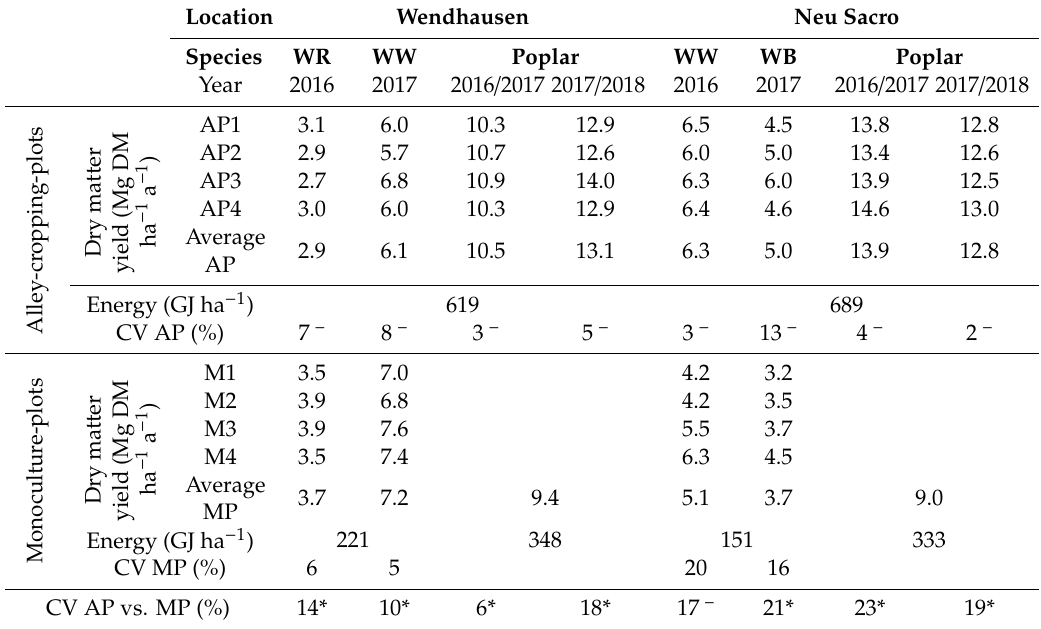
Table 2. Dry matter yields of wood and grains (winter wheat and winter barley) or seeds (winter rapeseed) per cropped area obtained from alley-cropping- and monoculture-plots at Wendhausen and Neu Sacro for the investigated years and their inferred gross energy yield. APs 1 and 2 were arranged leeward and APs 3 and 4 windward. The coe ffi cient of variation (CV) and level of significance are